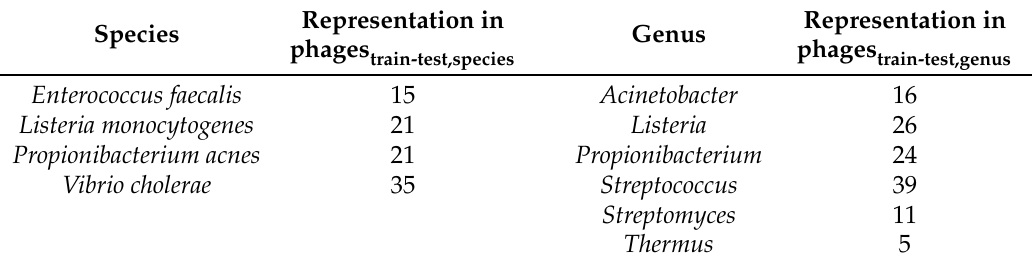
Table 3. List of host species (left) and genera (right), which HostPhinder predicts